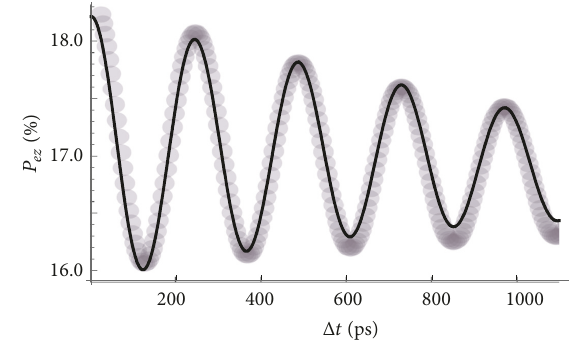
Figure 1: The spin polarization calculated in [28] (gray circles) and our results (black curve), to second order of the interaction picture, for level density of the bath 𝜌 𝜐 (𝜀) = 10 9 𝜖 𝑠 , with 𝑠 = 0.28 , and frequency 𝜔 𝑜 = 2.73556 × 10 10 s −1 . The gray circles graph published with author’s permission.